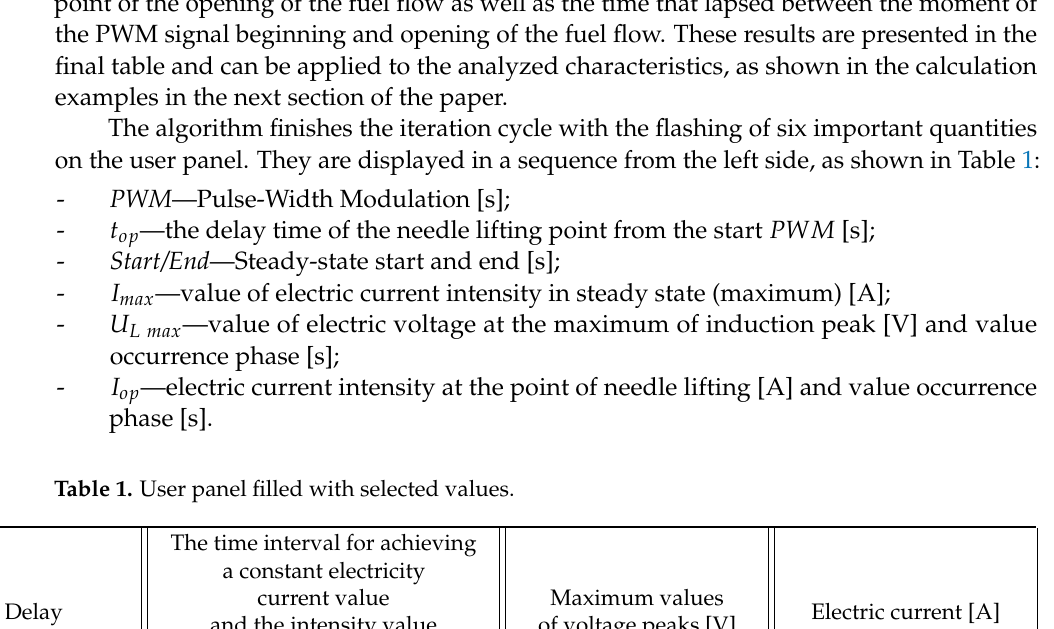
Figure 7. Finding the local minimum of the current intensity.